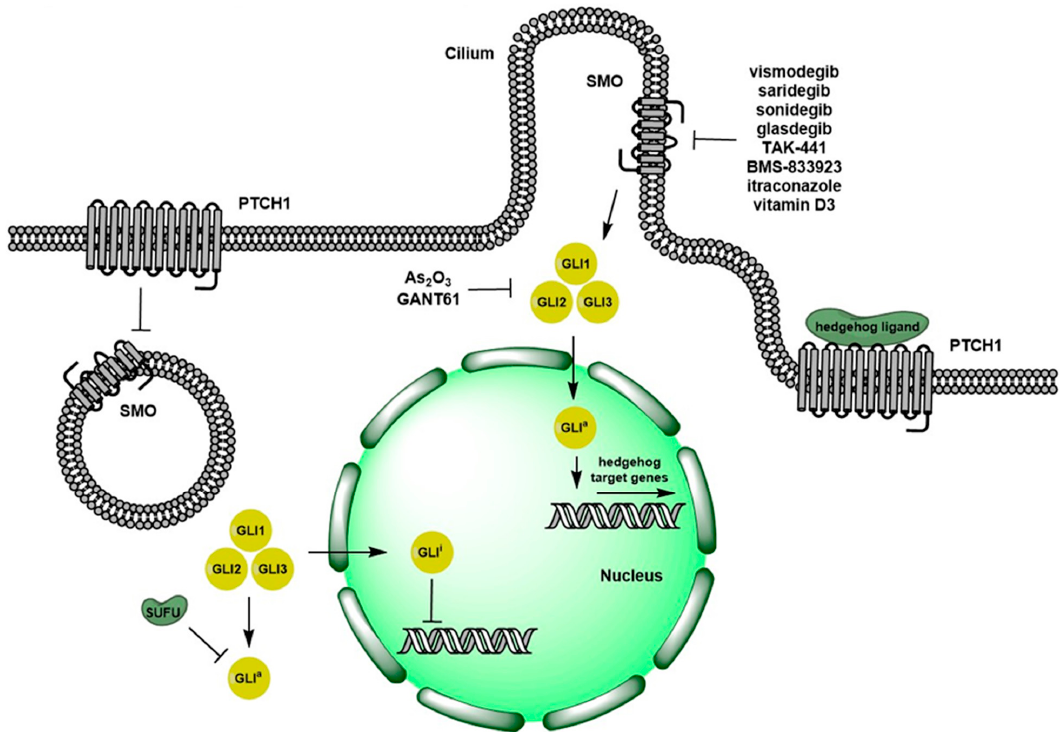
Figure 1. Schematic of Hedgehog signaling pathway. In the absence of Hh ligand binding, the receptor PTCH1 acts as a negative regulator of Hh pathway by inhibiting SMO. When Hh ligand binds to PTCH1, it releases the inhibition of SMO. Then, SMO initiates a downstream signaling cascade leading to the activation of GLI transcription factors, which translocate to the nucleus and induce Hh pathway target gene expression. GLIa: activated GLI. GLIi: inactivated